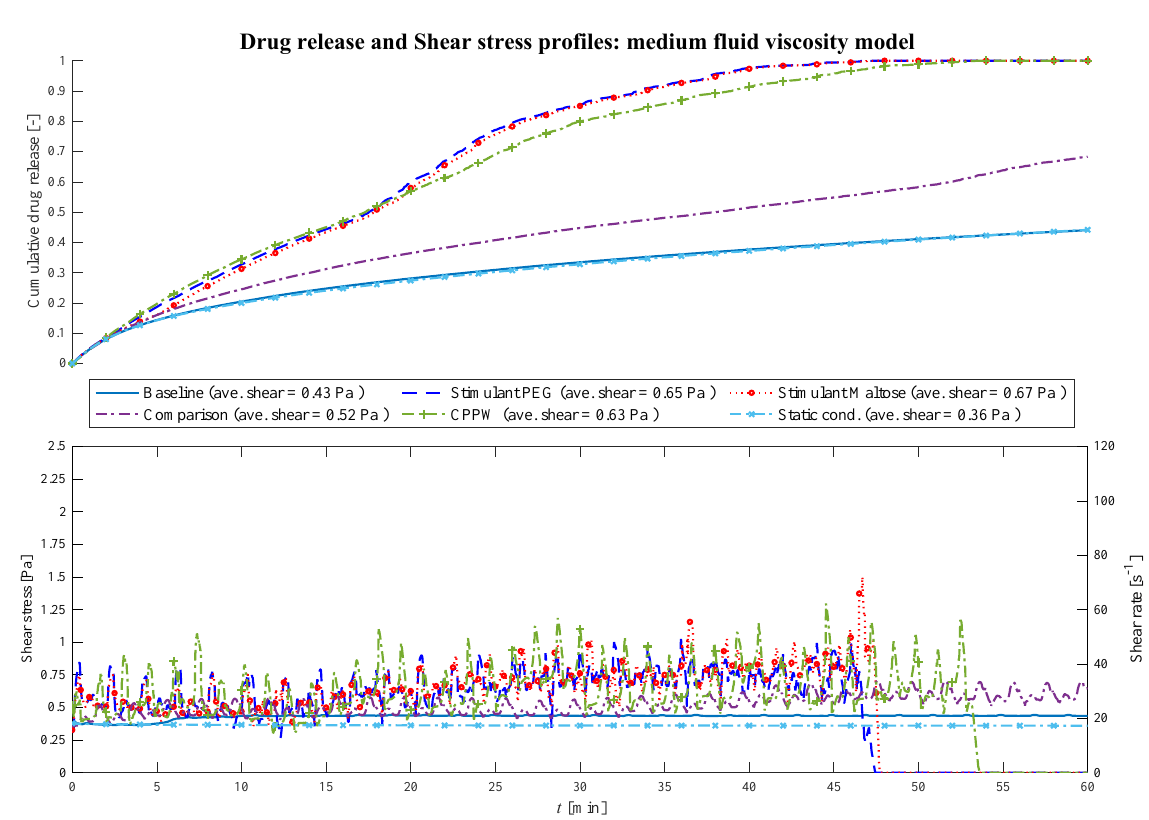
Figure 8. Comparison of the drug release profile of the different models at medium fluid viscosity conditions as well as the comparison of the shear stress/shear rate acting on the tablet.